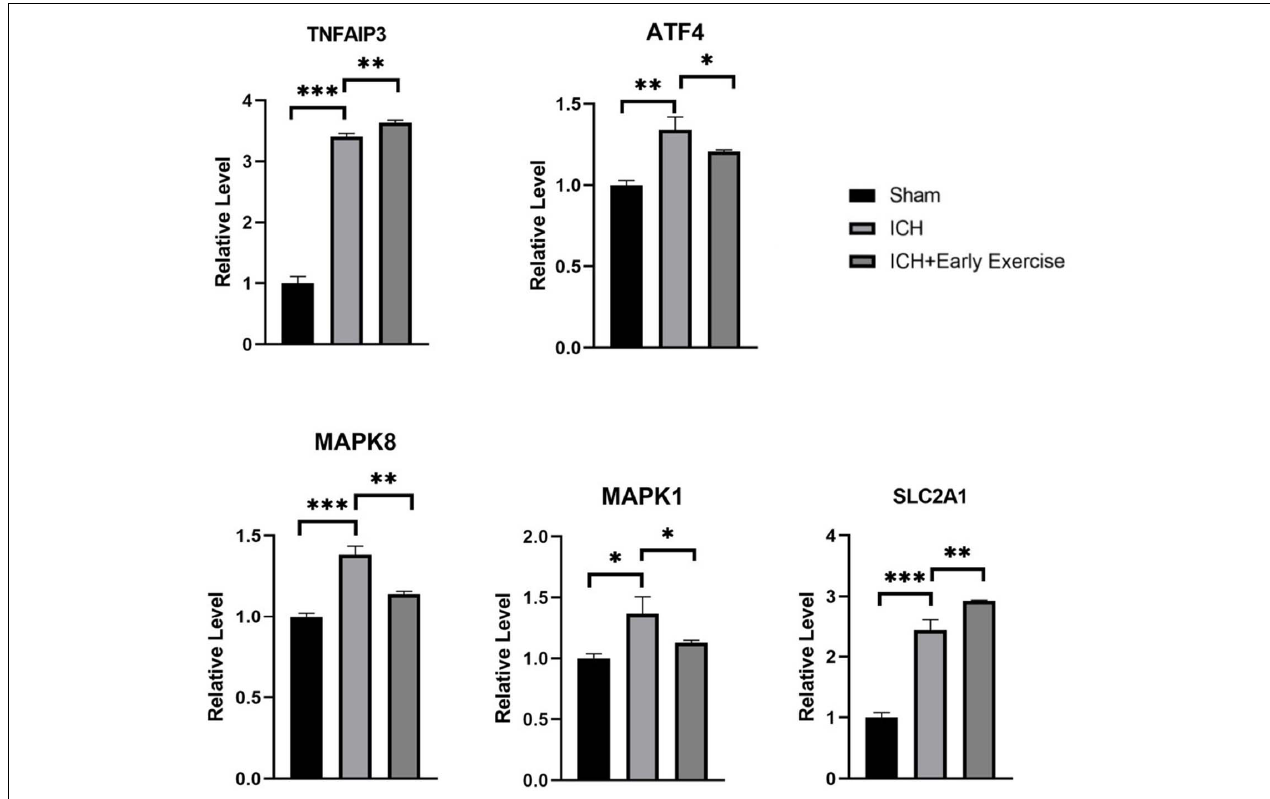
FIGURE 9 | qRT-PCR results show that the expression levels of MAPK1 ( P -value = 0.011), SLC2A1 ( P -value = 0.0002), TNFAIP3 ( P -value < 0.0001), and ATF4 ( P -value = 0.0022) were obviously higher, and MAPK8 ( P -value = 0.0003) was lower in intracerebral hemorrhage rats than that of healthy controls. After treadmill training, SLC2A1 ( P -value = 0.0087) and TNFAIP3 ( P -value < 0.0028) were obviously upregulated, and ATF4 ( P -value = 0.0468), MAPK8 ( P -value = 0.0017), and MAPK1 ( P -value = 0.0408) were downregulated by comparing the treatment group and the model